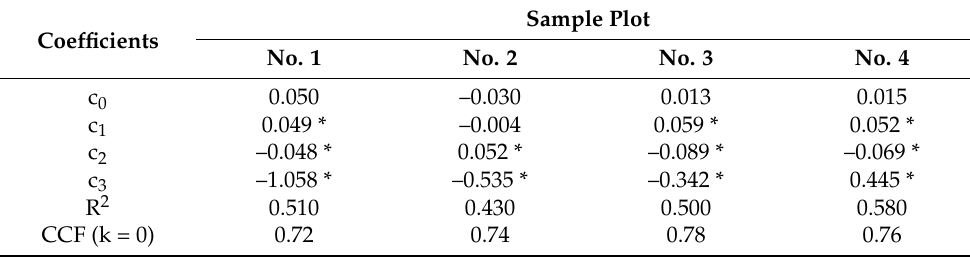
Table 4. Parameters of model (2) for sample plots.